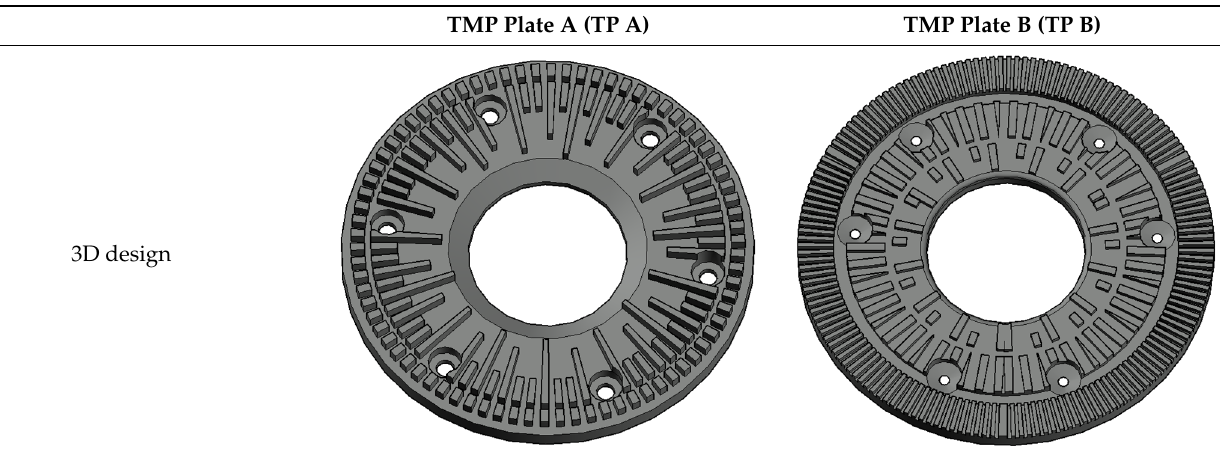
Table 3. Specification of two refiner plates with different patterns. Table 3. Speci fi cation of two re fi ner plates with di ff erent pa tt